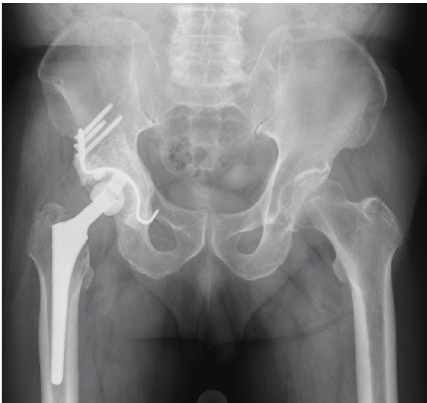
Figure 3: An anteroposterior plain radiograph, obtained 4 years after the rerevision surgery, showing acetabular reconstruction performed with a Kerboull-type acetabular reinforcement device and bulk structural